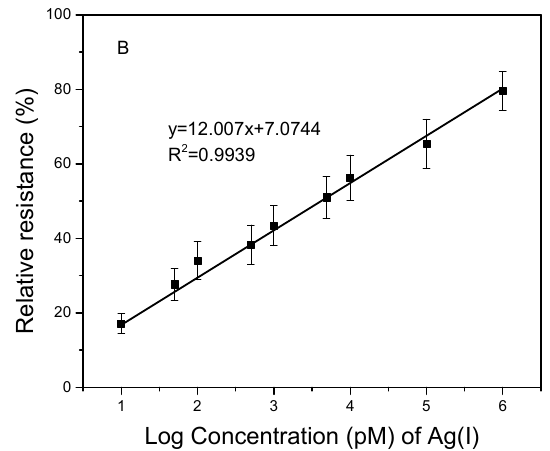
Figure 9. The determination of Ag(I). ( A ) Relative resistance change after exposed to different concentrations of 10, 50, 100, 500, 1000, 5000, 10,000, 100,000, 1,000,000, 10,000,000, and 100,000,000 pM. ( B ) The response linearity between the relative resistance and the logarithm of Ag(I) concentration.